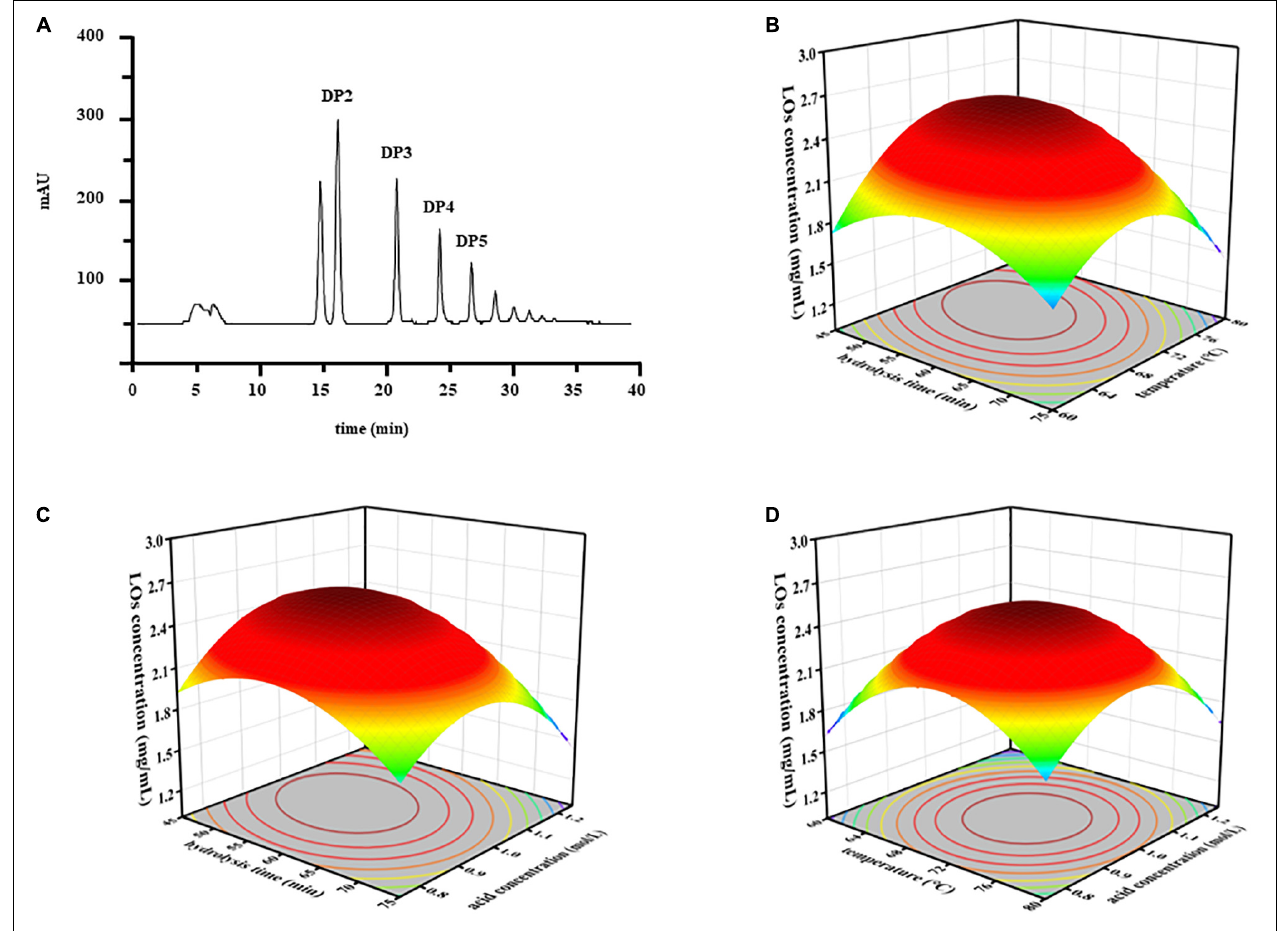
FIGURE 1 | (A) The chromatograms of LOs separated by HPLC-ELSD. The response surface plots of the interaction effects of independent variables on the LOs production. (B) Hydrolysis time and temperature; (C) hydrolysis time and acid concentration; (D) temperature and acid concentration.